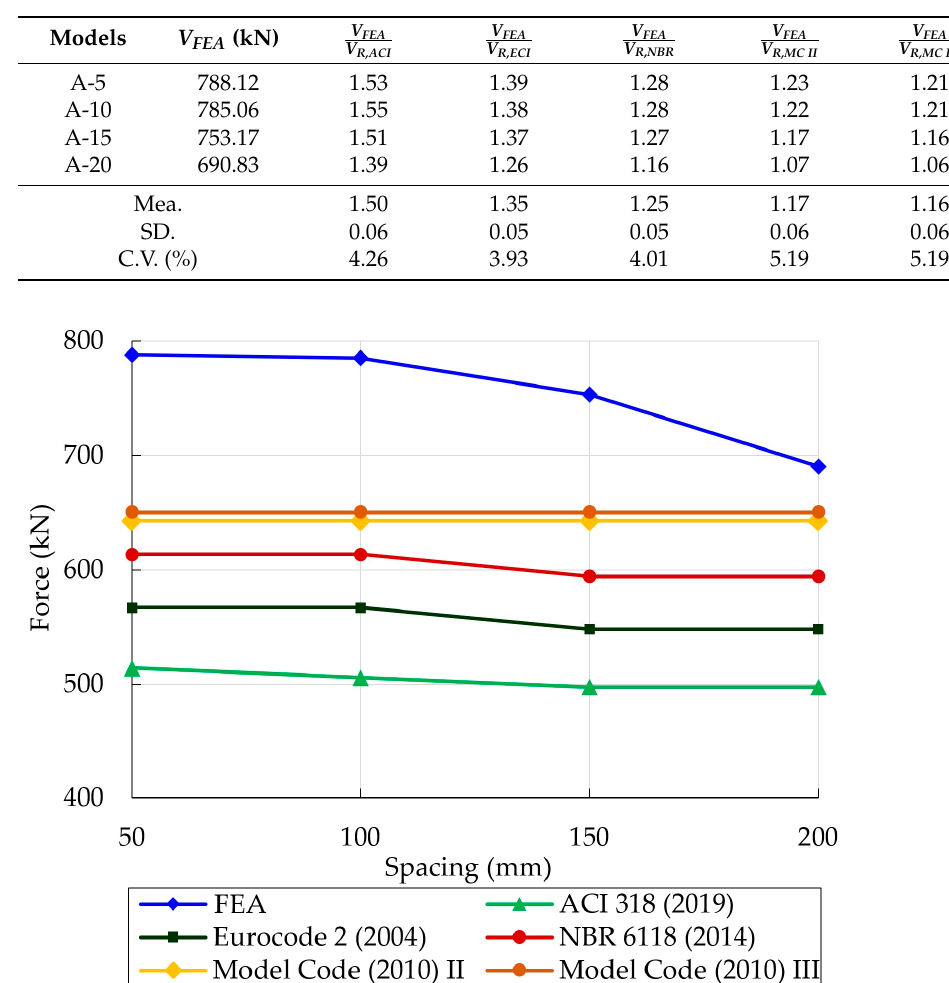
Table 6. Comparison between numerical and theoretical breaking loads (Series A).